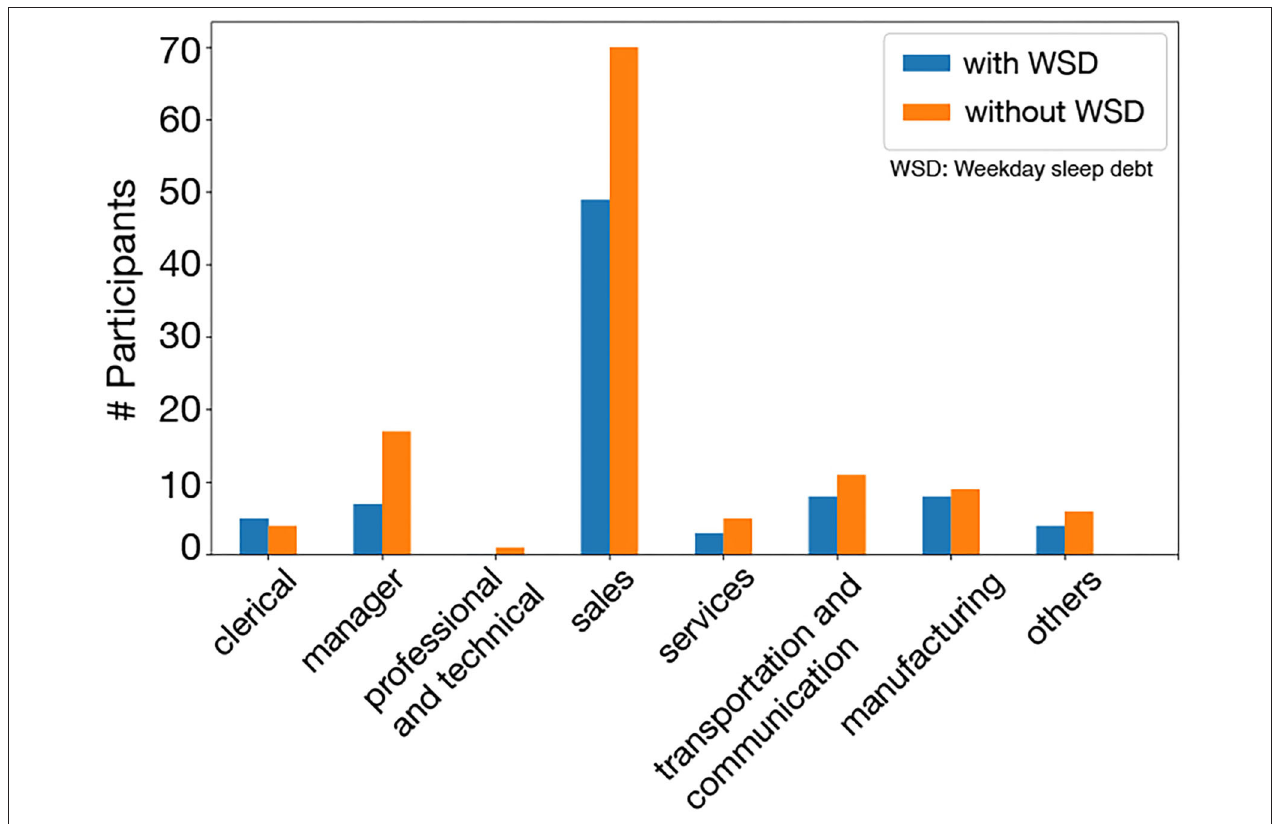
FIGURE 6 | WSD and non-WSD groups in occupational categories: in all categories, there was not much difference between the WSD and the non-WSD groups.